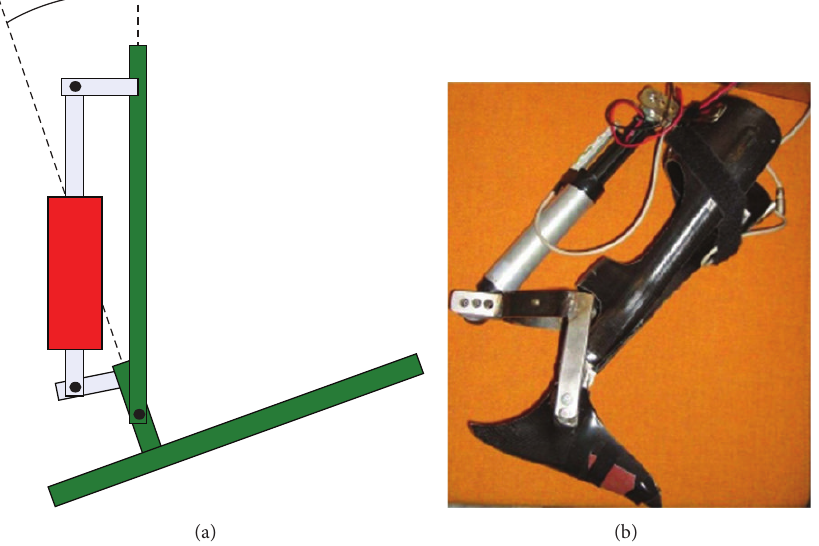
Figure 8: Halmstad University AFO with MR fluid damper; here 𝛼 is the adjustable ankle angle [32].